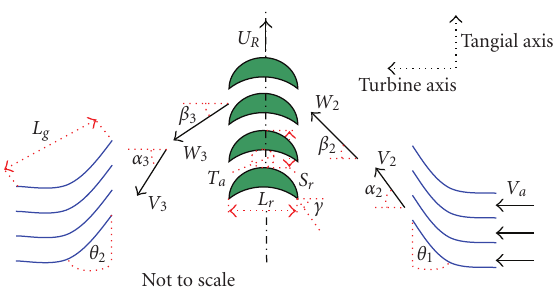
Figure 2: Impulse turbine geometry and velocity